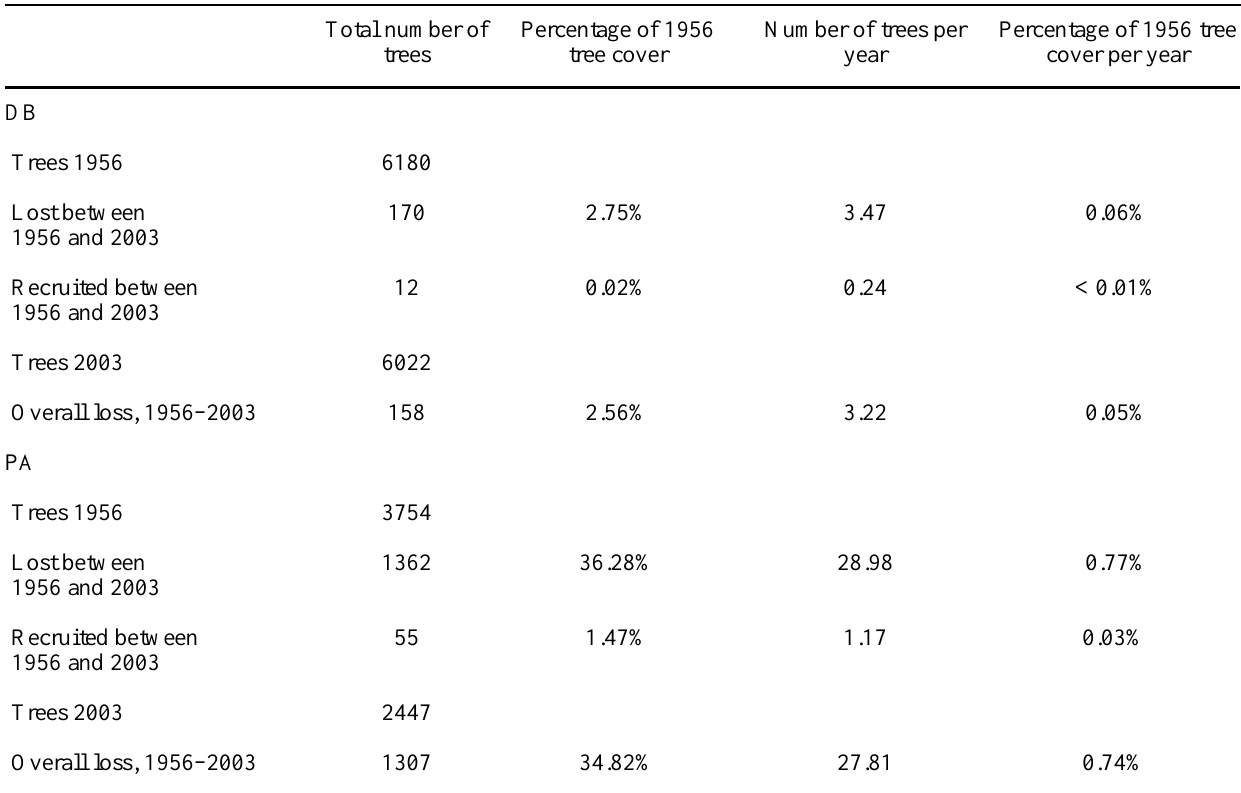
Table 4 . Total number and percentage of trees lost and recruited in the Dehesa Boyal (DB) and Parapuños de Doña María (PA) sites,